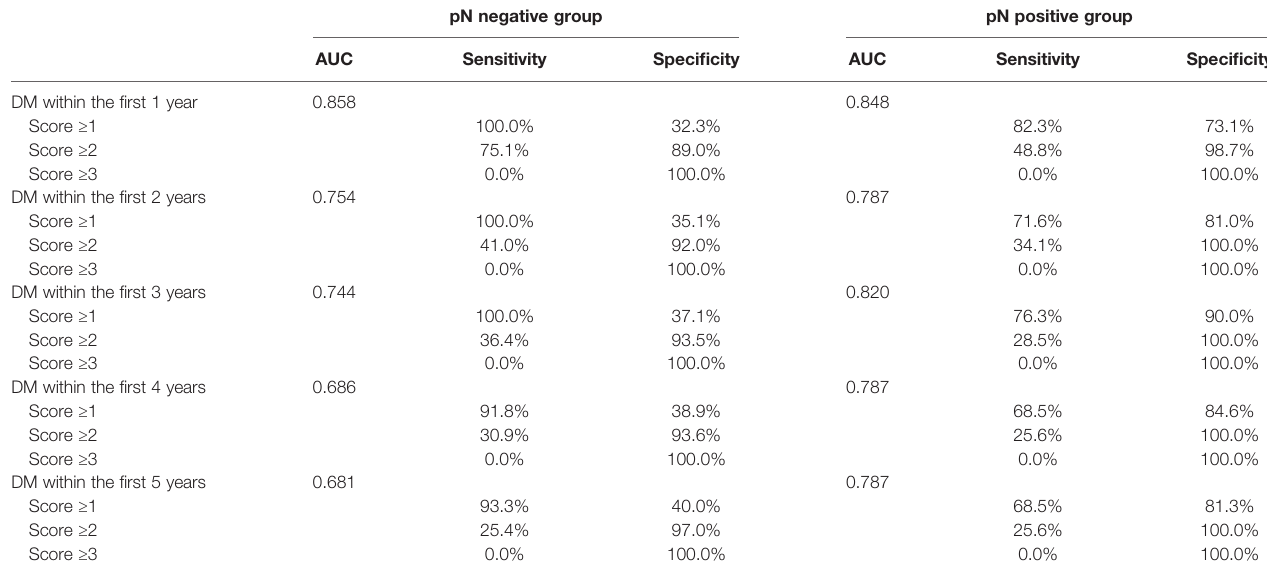
TABLE 3 | Areas under the curve (AUCs), sensitivity, and speci fi city of the score models to predict distant